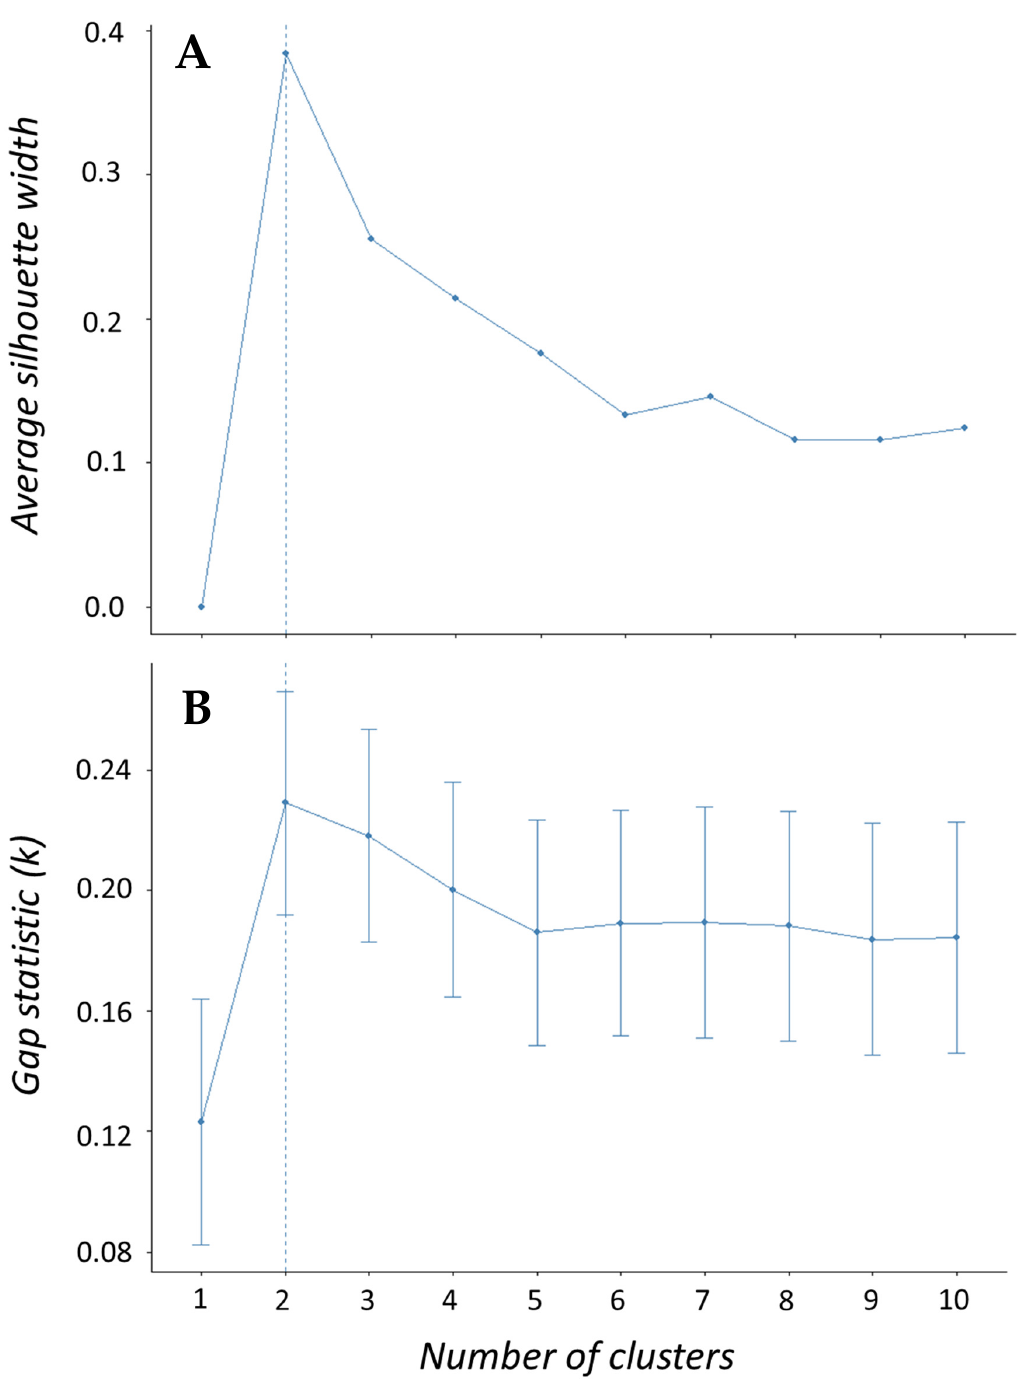
Figure A1. Graph depicting two common methods to determine optimal number of clusters to be used in a hierarchical cluster analysis. Methods include ( A ) average silhouette, which measures how well data lies within each cluster so that higher values indicate better fit, and ( B ) the gap statistic, which compares intracluster variation to a null reference and clusters with highest values representing the greatest distance from